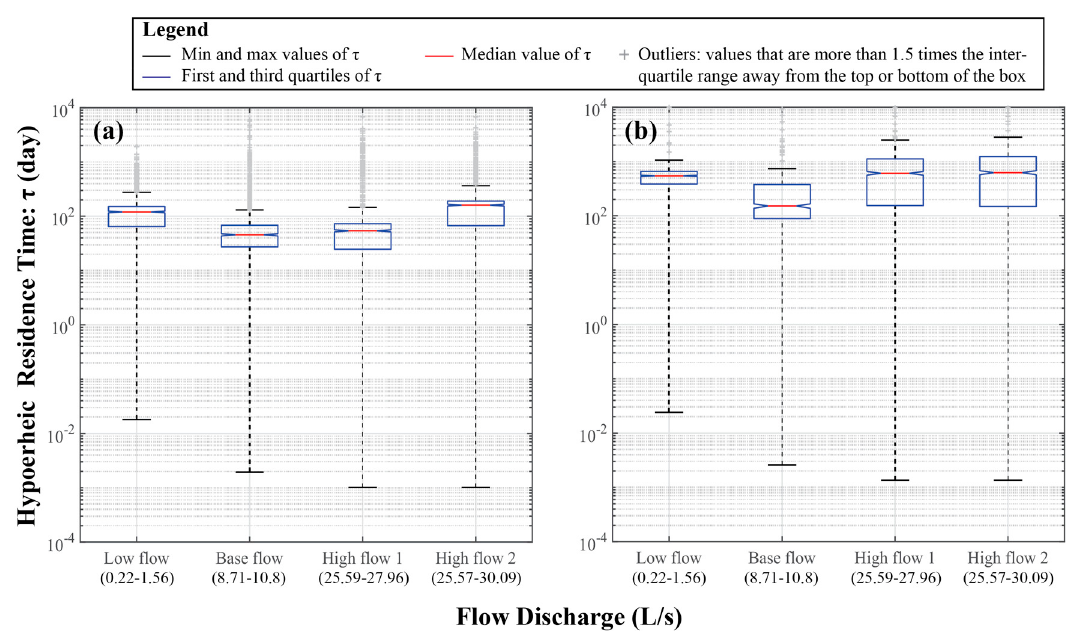
Figure 6. Box and whisker plots of hyporheic fluxes residence time under various flow discharges assuming ( a ) constant intrinsic permeability ( k = 10 − 9 [m 2 ]) for the entire subsurface region and ( b ) decaying intrinsic permeability (starting from k ( z = 0) = 10 − 9 [m 2 ] at the surface–subsurface water interface and decaying exponentially to k ( z = − 1) = 10 − 12 [m 2 ] down to a depth of 1 m). In the case of vertically varying permeability, a constant permeability ( k = 10 − 12 ) was used for depths larger than 1 m. The second row of the horizontal axis (i.e., numbers), are the ranges of stream flow discharge along the stream for each flow regime. τ : residence time of the particles released at the streambed interface.